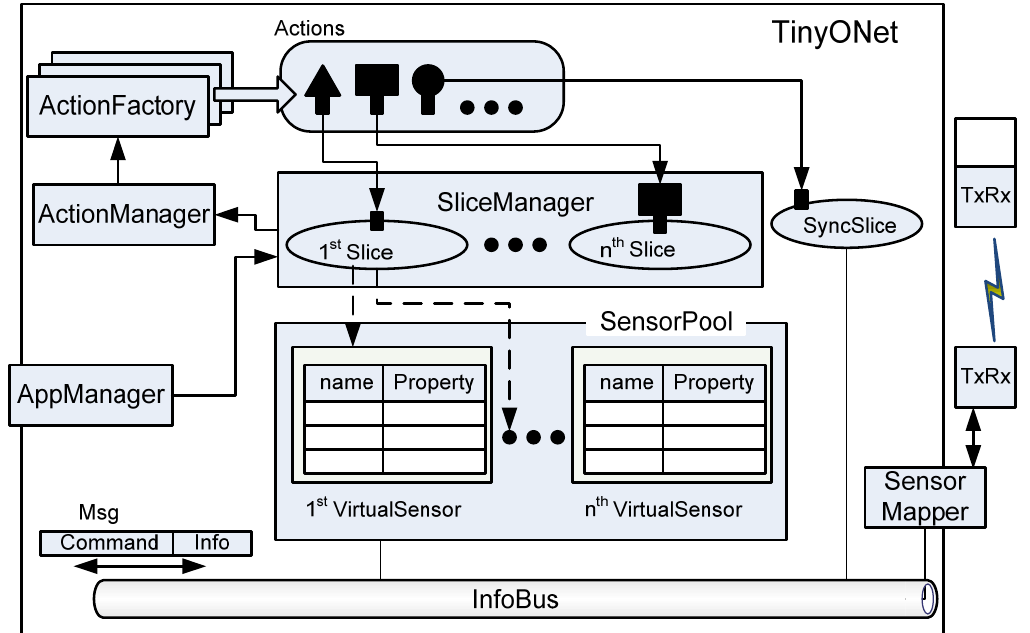
Figure 2. Components of